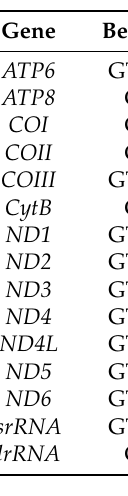
Table 5. Best evolutionary models selected by